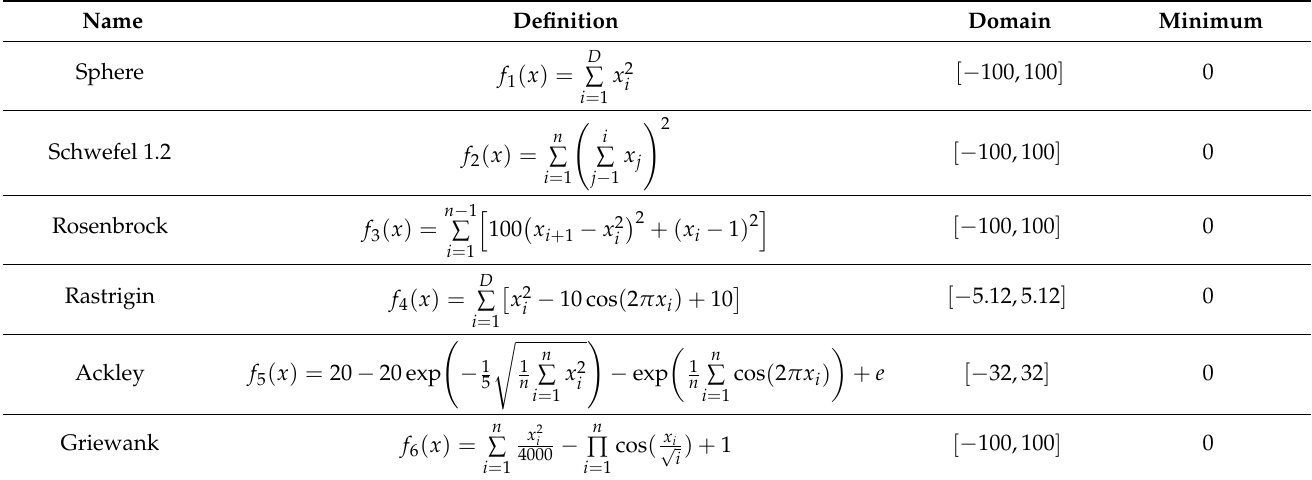
Table 3. Six benchmark